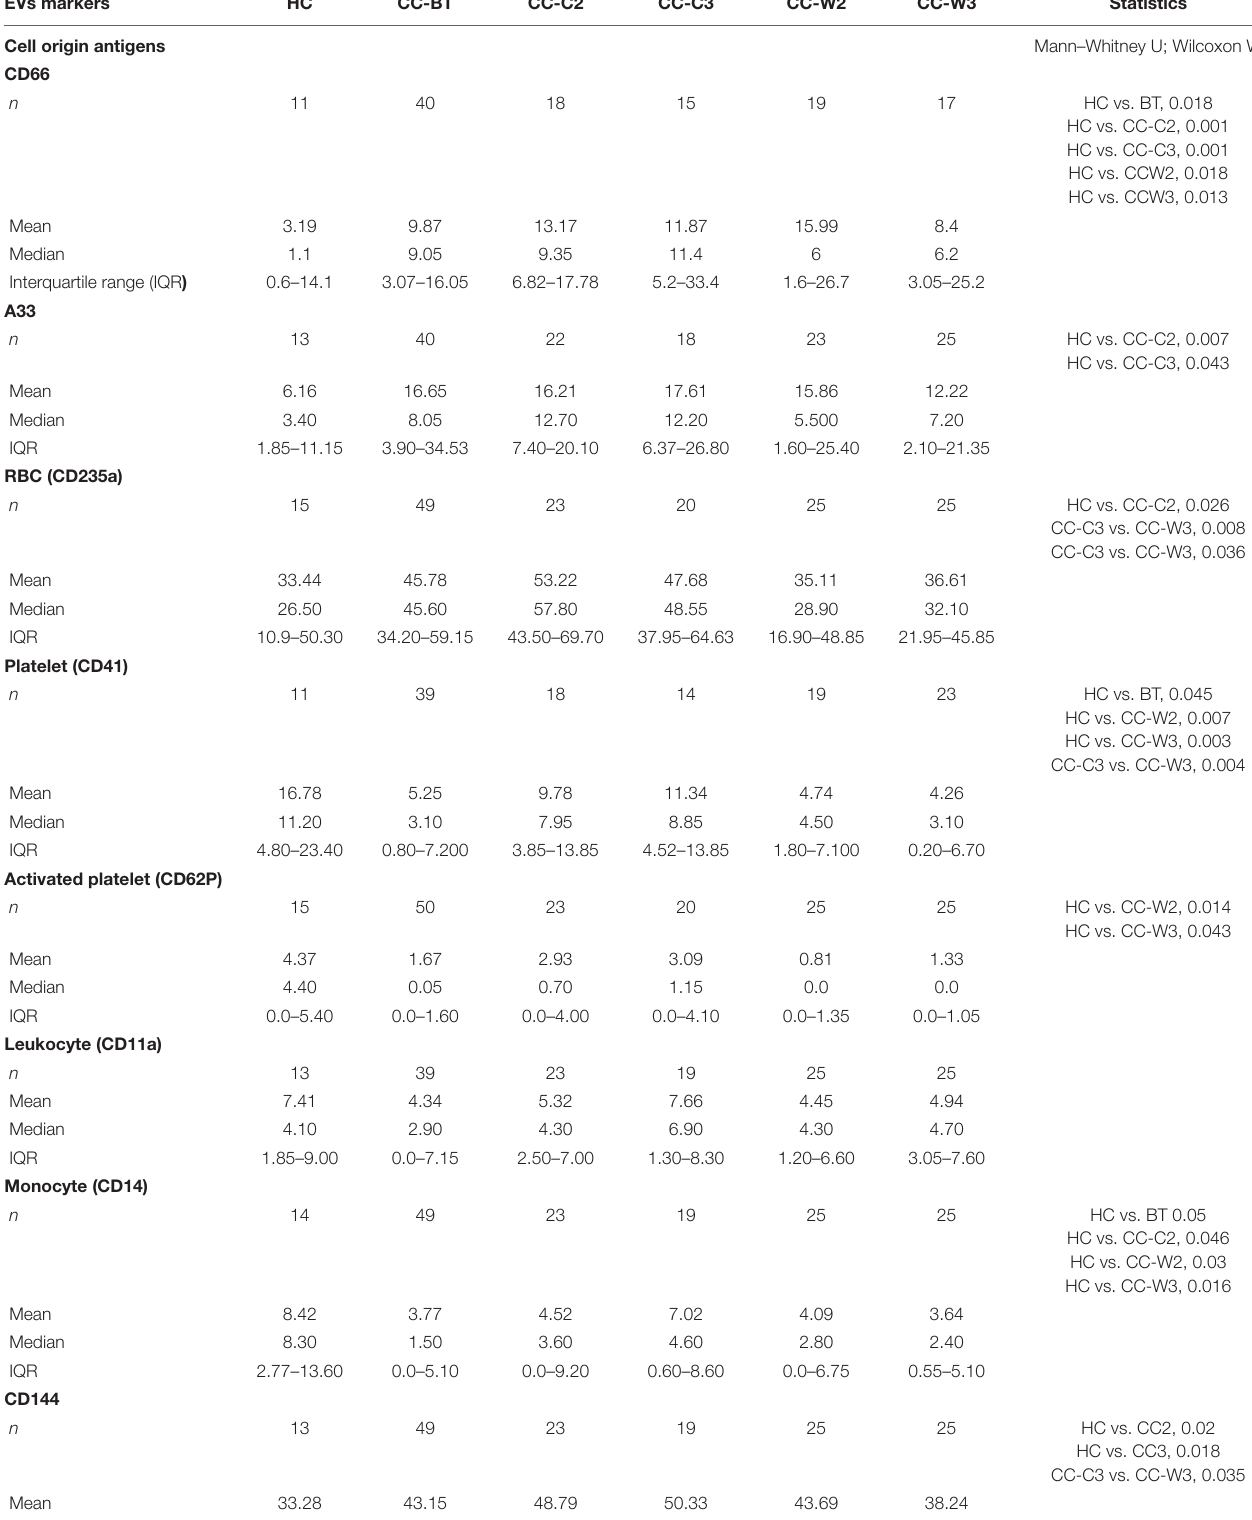
TABLE 2 | EV cell origin membrane antigen